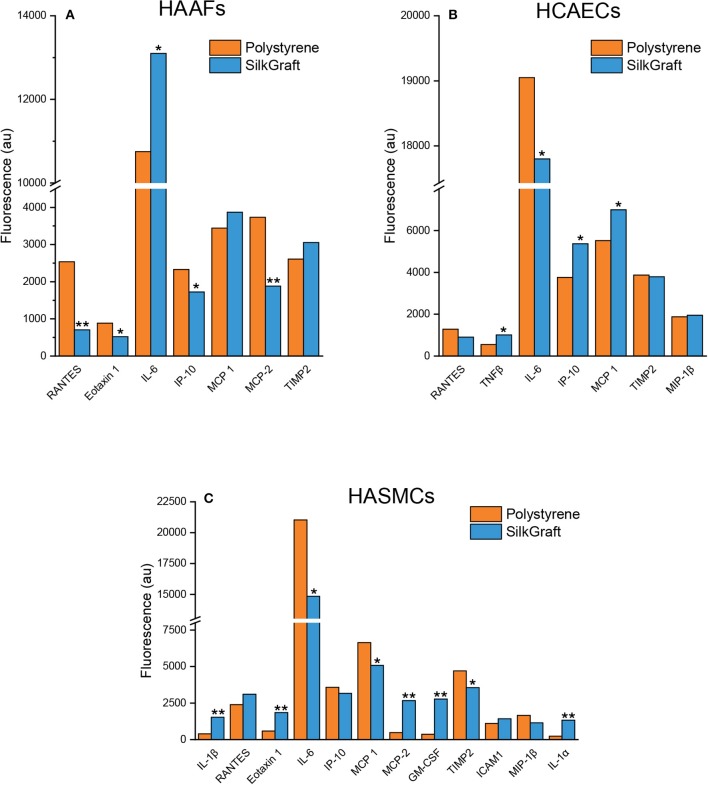
Relevant cytokines and chemokines secreted by each cell type cultured between 18 and 20 days on SilkGraft and polystyrene: HAFFs (A), HCAECs (B), and HASMCs (C). Results of immunofluorescence intensities were normalized to 103 cells. IL-6: Interleukin-6; MCP-1: Monocyte chemoattractant protein-1; TIMP-2: Tissue inhibitor of metal proteinases-2; IP-10: Interferon gamma-induced protein-10; MCP-2: Monocyte chemoattractant protein-2; Eotaxin-1; RANTES: Regulated on activation normal T cell expressed and secreted; MIP-1β: Macrophage inflammatory protein-1β; TNF-β: Tumor necrosis factor-β; GM-CSF: Granulocyte-macrophage colony stimulating factor; IL-1α: Interleukin-1α; IL-1β: Interleukin-1β; ICAM-1: Intercellular adhesion molecule-1. The bars are the mean values of three independent experiments corrected for cell numbers. *P < 0.01; **P < 0.001. SEMs, not shown, ranged between 5 and 10% of corresponding mean values.